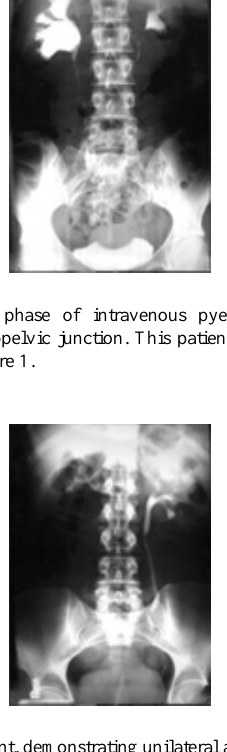
FIGURE 3. Index patient, demonstrating unilateral absence of right kidney.